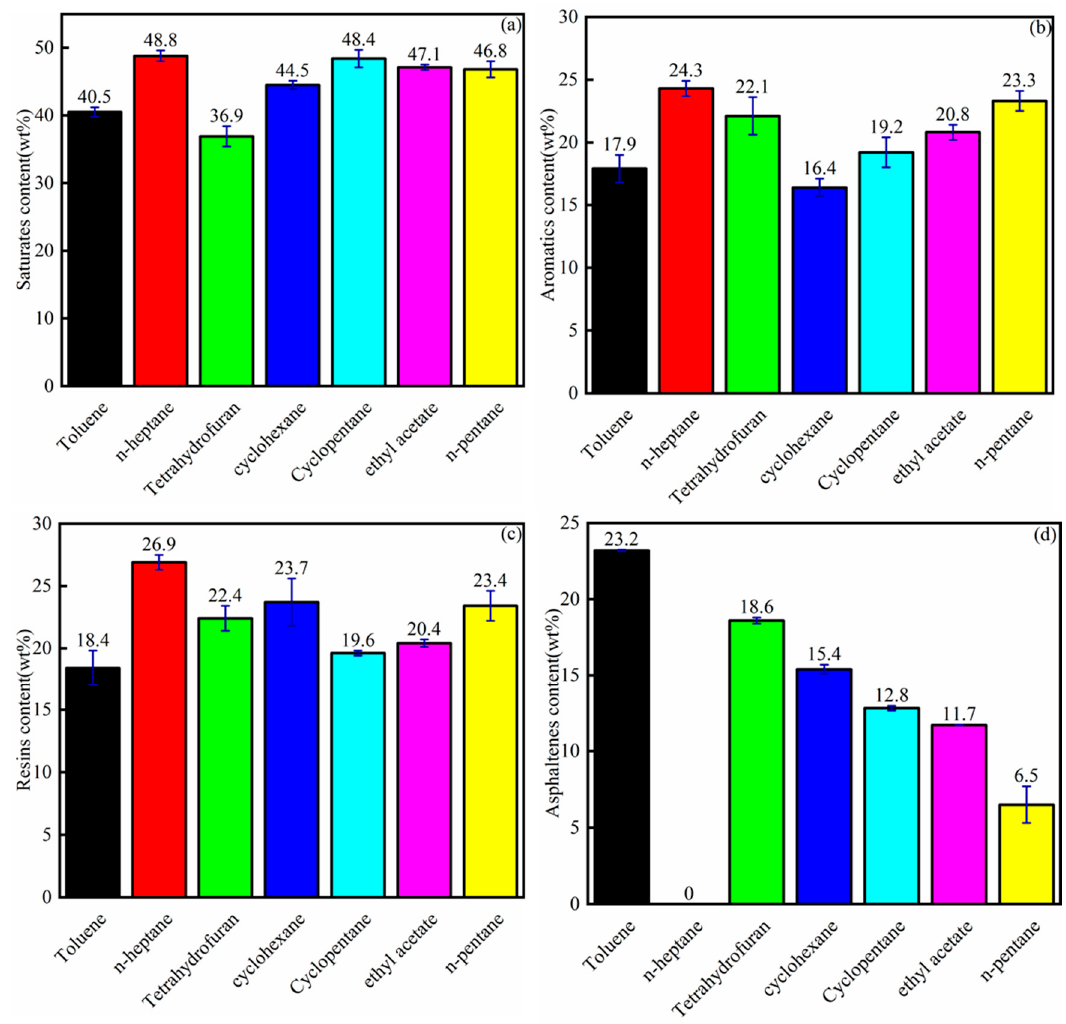
Figure 6. Saturates ( a ), aromatics ( b ), resins( c ) and asphaltenes ( d ) contents of the bitumen from different single solvent extraction experiments.